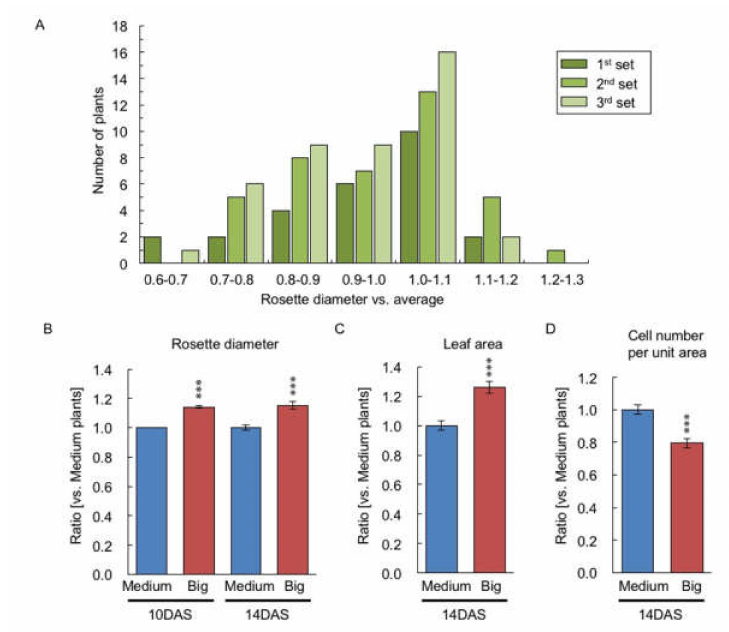
Figure 2. Comparison of the rosette diameter and true leaf area and its cell number per unit area between medium- and big-sized F 1 plants. ( A ) Distribution of ratio of rosette diameter compared with average of rosette diameter in F 1 plants ( n = 103) at 10 DAS. Three replicates were performed represented as first, second, and third sets. ( B ) Ratio of rosette diameter compared with medium-sized F 1 plants in big-sized F 1 plants at 10 and 14 DAS. ( C ) Ratio of leaf area of first and second leaves compared with medium-sized F 1 plants in big-sized F 1 plants at 14 DAS. ( D ) Ratio of cell number per unit area in the first layer of palisade mesophyll cell compared with medium-sized F 1 plants in big-sized F 1 plants at 14 DAS. Data presented are the average and standard error (s.e.) (each, n = 22). *** p < 0.001 (Student’s t